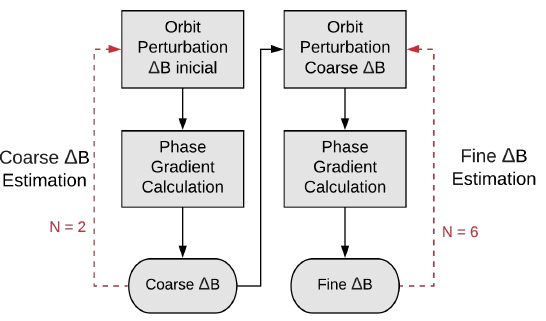
Figure 17. Detailed workflow to describe the coarse and fine step present in the general workflow (Figure 16). In each step, the orbit perturbation takes as argument both ∆ B ⊥ and ∆ B (cid:107) . It is important to note that when estimating ∆ B ⊥ the initial values for both parameters are zero. Instead, when estimating ∆ B (cid:107) , the fine estimation of ∆ B ⊥ is passed as a fixed parameter, as illustrated by figure